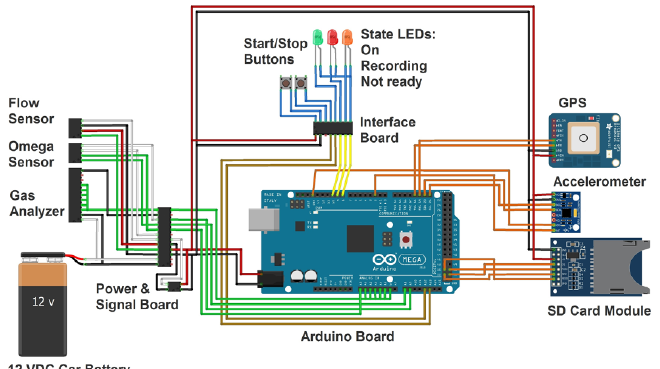
Figure 4. Data acquisition system’s wiring